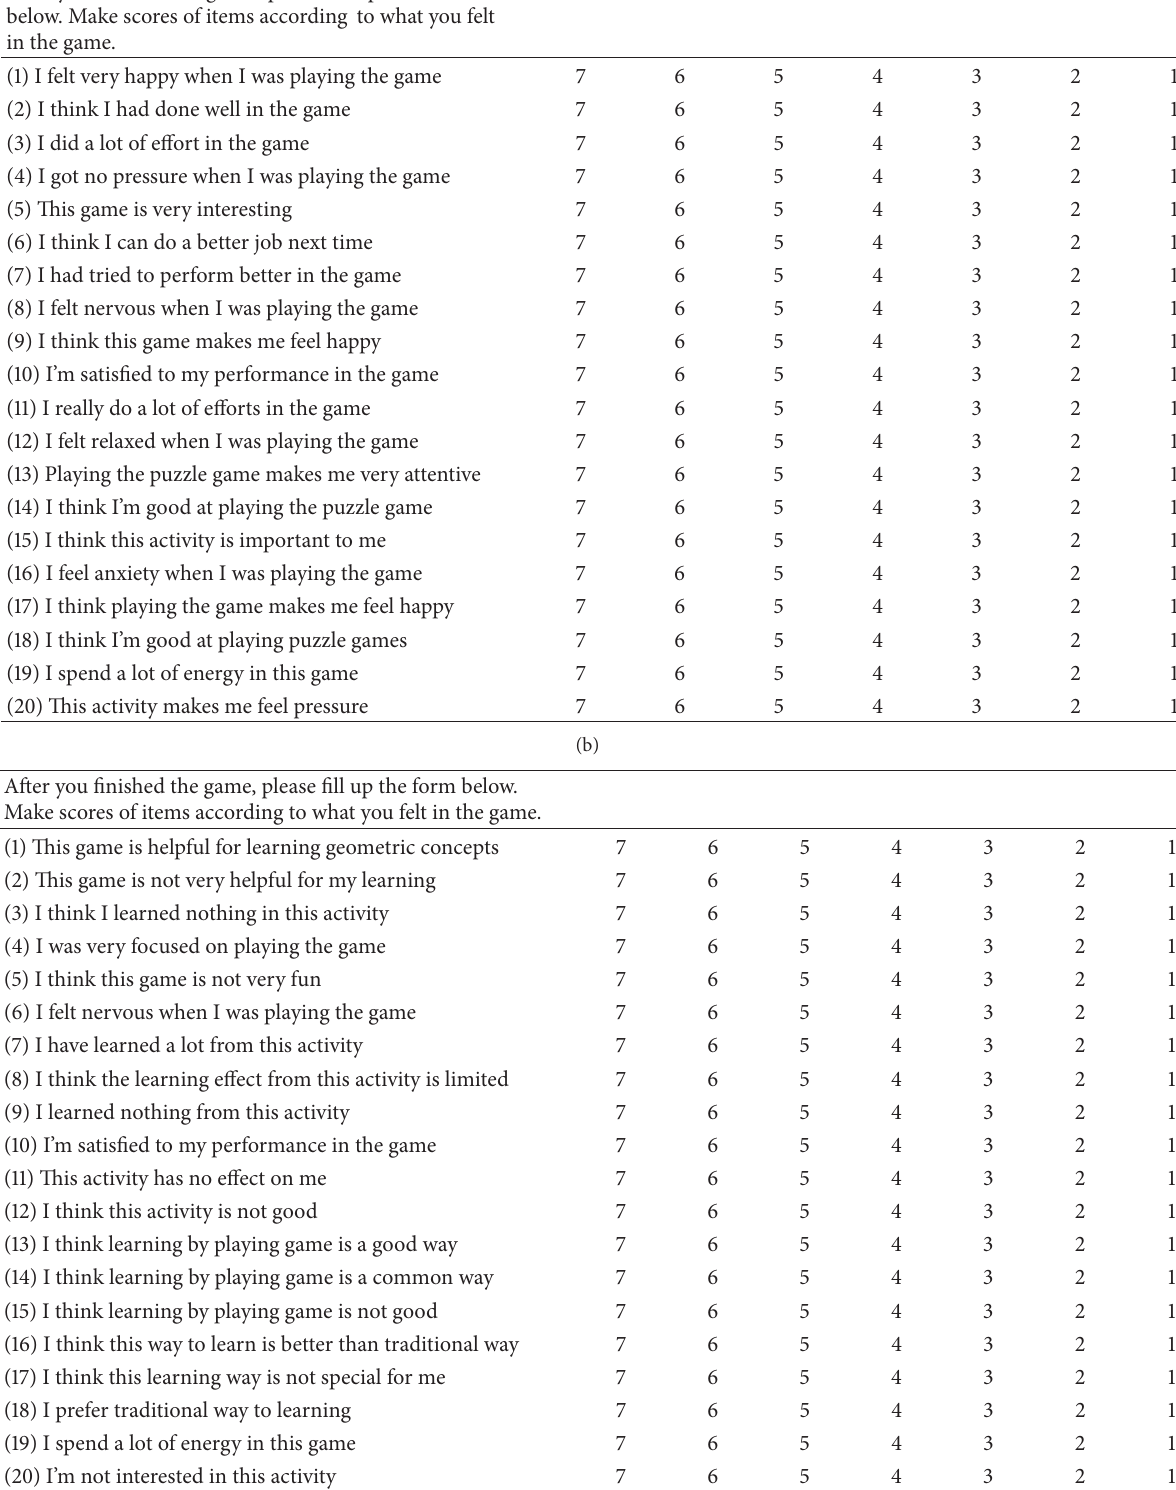
Table 3: Contents of the questionnaire in this